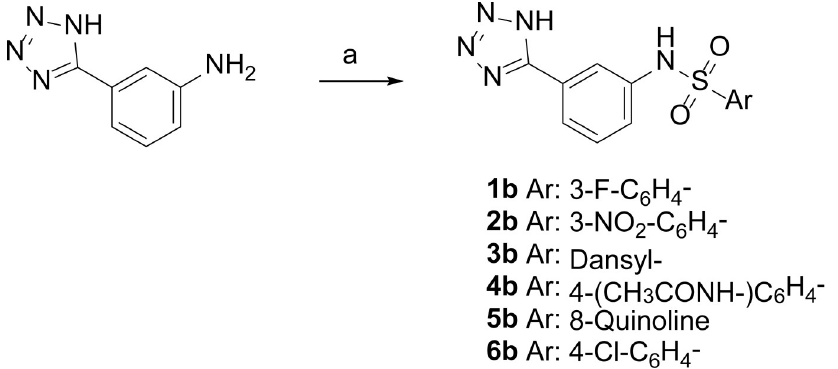
Fig 13. Reagents and conditions. a) aryl-sulfonyl chloride (1.2 eq.), pyridine (3 eq.), dry DCM, N 2 , r.t, 3 h, 75–95% yield.